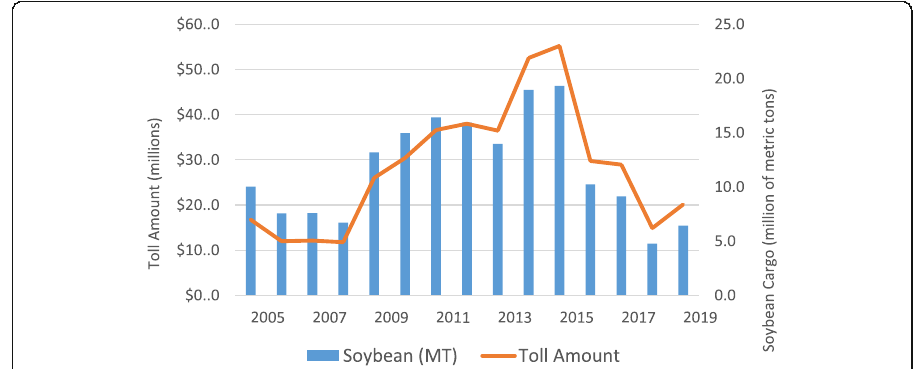
Fig. 2 Soybeans Flows and Total Toll Amount for Vessels Carrying Soybeans. Source: Panama Canal internal